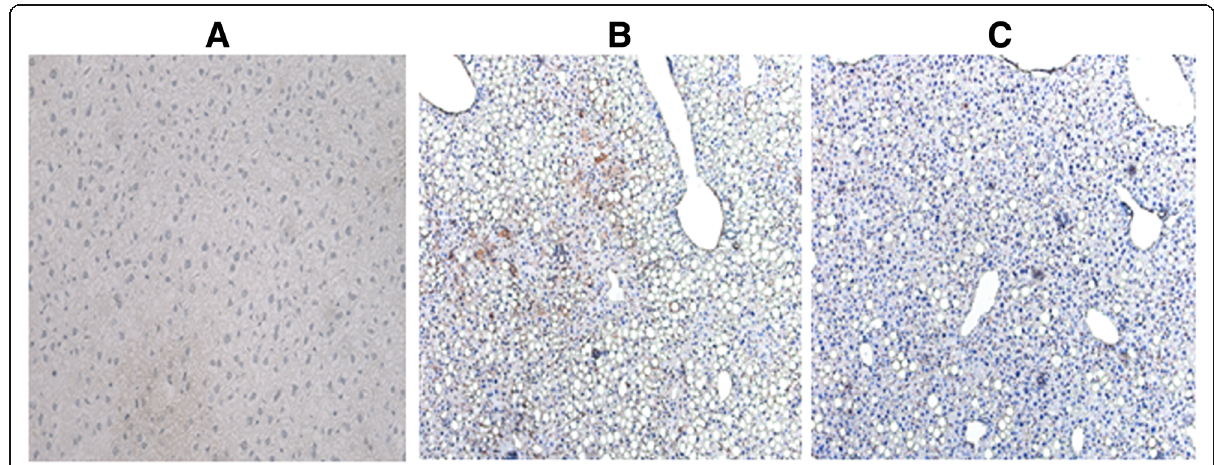
Fig. 4 The Alisma and Rhizoma decoction suppresses α -SMA expression in the hepatic tissues of mice with MCD-induced NASH. The liver tissues of mice receiving regular diet ( a ), MCD ( b ) and MCD plus the A. oriental - R. atractylodis macrocephalae decoction ( c ) were examined by immunohistochemistry for α -SMA. Brown-stained cells are α -SMA positive. Magnification, 100